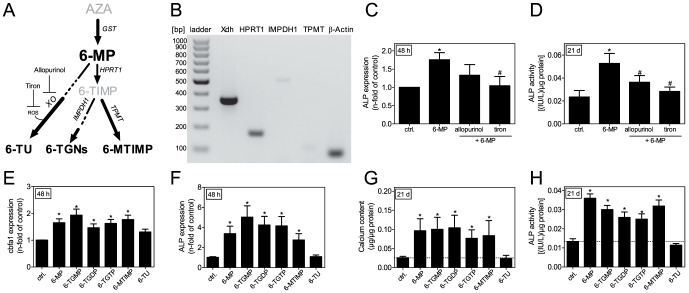
Effects of 6-MP metabolites.(A) Metabolism scheme of the prodrug AZA. (B) Expression of Xdh (351 bp), HPRT1 (168 bp), IMPDH1 (505 bp), TPMT (104 bp), and β-actin (76 bp) in unstimulated VSMCs. (C,D) Effect of 6-MP (100 µmol/L), allopurinol (5 µmol/L) and tiron (100 µmol/L) stimulation on VSMC (C) ALP mRNA expression and (D) ALP enzyme activity. Enzyme activity was normalized to the protein content of the cells. Data represents means±SEM, n≥6, *p<0.05 vs. control #p<0.05 vs. 6-MP. (E,F) VSMCs were stimulated with 6-MP (100 µmol/L), 6-TGNs (each 10 µmol/L), 6-MTIMP (10 µmol/L) or 6-TU (10 µmol/L) for 48 h and (E) cbfa1, and (F) ALP mRNA expression levels were analyzed. Data represents means±SEM, n≥6, *p<0.05 vs. control. (G,H) VSMCs were incubated as indicated (100 µmol/L 6-MP, 6-TGNs [each 10 µmol/L], 6-MTIMP or 6-TU [each 10 µmol/L] for 21 days) and (G) calcium content and (H) ALP enzyme activity were measured. Data represents means±SEM, n≥6,*p<0.05 vs. control. AZA: azathioprine, cbfa1: core binding factor alpha-1, GST: glutathione S-transferase, HPRT: hypoxanthine guanine phosphoribosyltransferase, IMPDH1: inosine monophosphate dehydrogenase 1, 6-MP: 6-mercaptopurine, 6-MTIMP: 6-methylthioinosine monophosphate, 6-TGDP: 6-thioguanosine diphosphate, 6-TGMP: 6-thioguanosine monophosphate, 6-TGNs: 6-thioguanine nucleotides, 6-TGTP: 6-thioguanosine triphosphate, 6-TIMP: 6-thioinosine monophosphate, TPMT: thiopurinemethyltransferase, 6-TU: 6-thiouric acid, Xdh: Xanthine dehydrogenase, XO: xanthine oxidase.